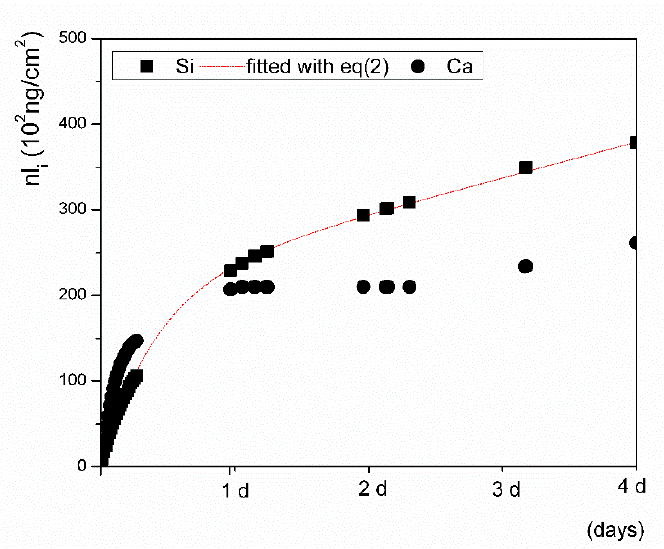
Figure 6. Flow-through test results of ion release in SBF for nl(Si) = f(t) (black square) as fitted with an empirical equation (dotted line) when compared to nl(Ca) = f(t) . an empirical equation (dotted line) when compared to nl(Ca) = f(t).